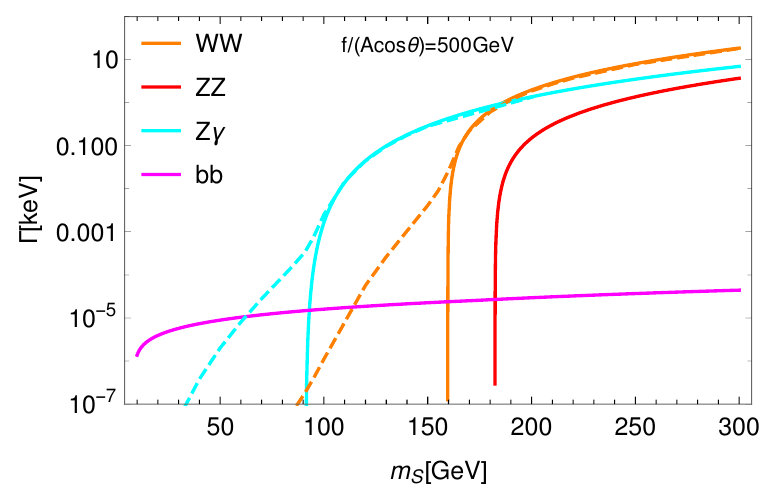
Figure 14 . Partial width of S in the dominant decay channels for the composite Higgs model benchmark scenario discussed in section 2.3. The dashed lines denote the contribution with at least one o(cid:11)-shell weak